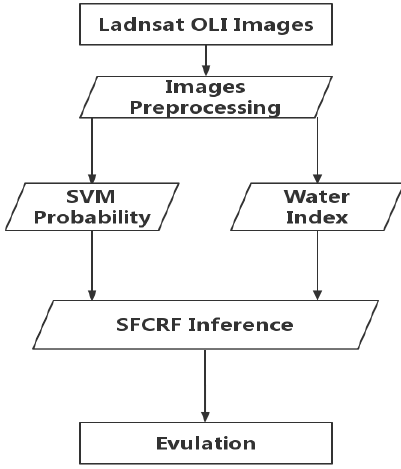
Figure 1. Flowchart of SVM-WIGSFCRF algorithm for water extraction